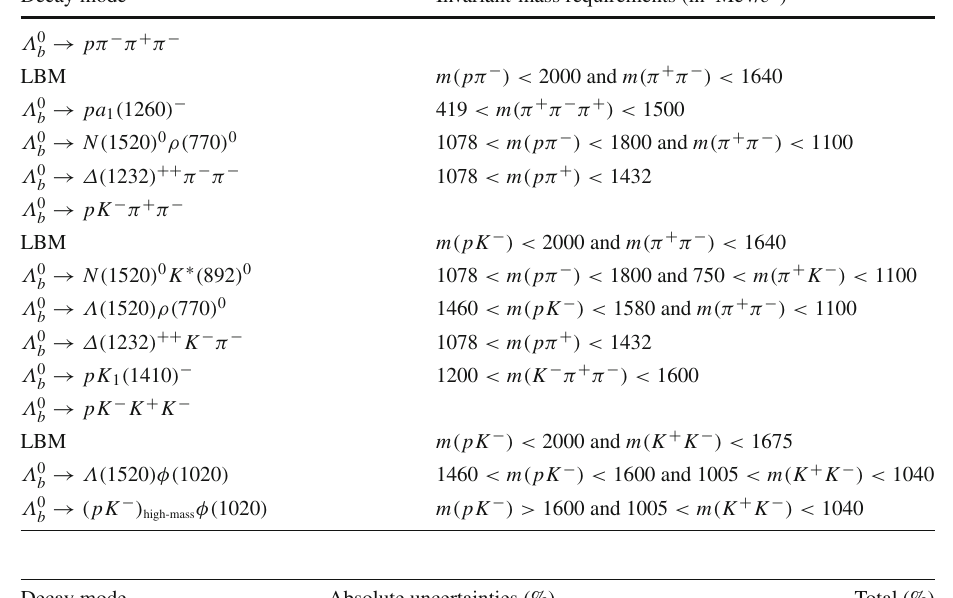
uncertainties for each decay mode. The uncertainties related to the kaon and proton detection asymmetry, the difference of triggering efficiency, the PID asymmetries and the production asymmetry are respectively reported as σ K , σ p , σ L0 , σ PID and σ A P